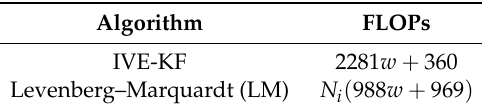
Table 7. Comparison of